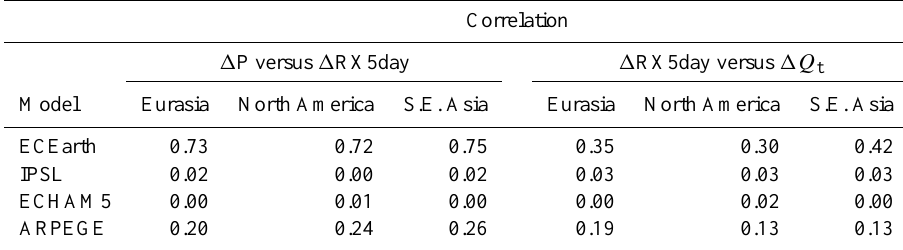
Table 4. Correlation coefficients between the change in precipitation and the change in RX5day due to LULCC and between the change in RX5day and the change in the sum of the latent and sensible heat